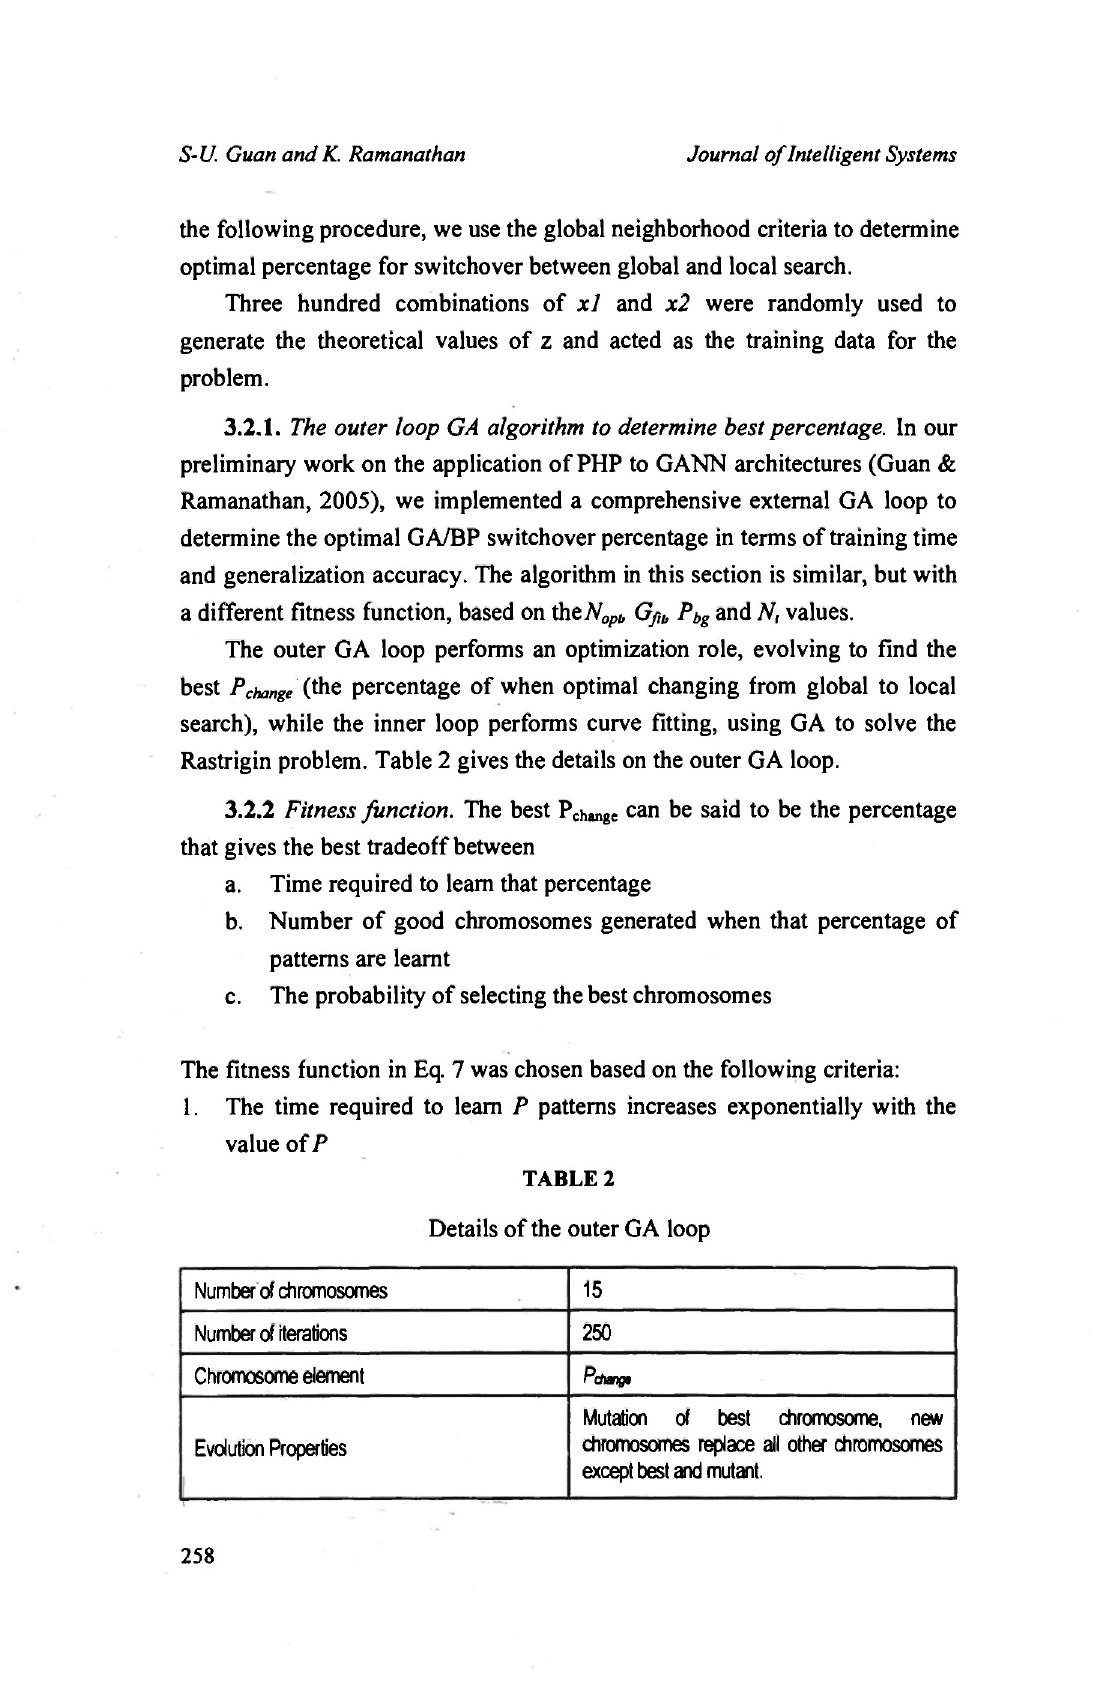
Details of the outer GA